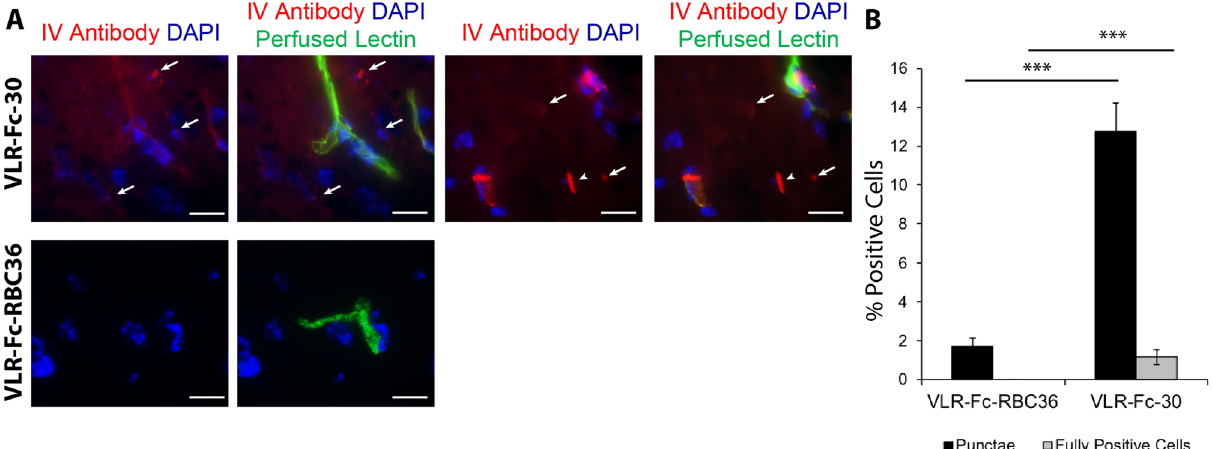
Figure 9. Mice were administered 10 mg/kg of the indicated antibody construct (red). After 11 h of circulation time, mice were perfused with saline containing fluorescently labeled lectin (green) to remove unbound VLR-Fc and label the vascular lumen. ( A ) Postvascular accumulation of VLR-Fc-30 was visualized as punctae (full arrows) and fully positive cells (arrow heads). Scale bars = 15 μm. ( B ) Quantification of percentage of DAPI positive cells exhibiting post vascular uptake of VLR-Fc-30 compared to VLR-Fc-RBC36 n = 3 injected animals, a total of 1007 and 1287 DAPI positive cells were analyzed for VLR-Fc-RBC36 and -30 respectively, p < 0.001 = ***determined using one-way